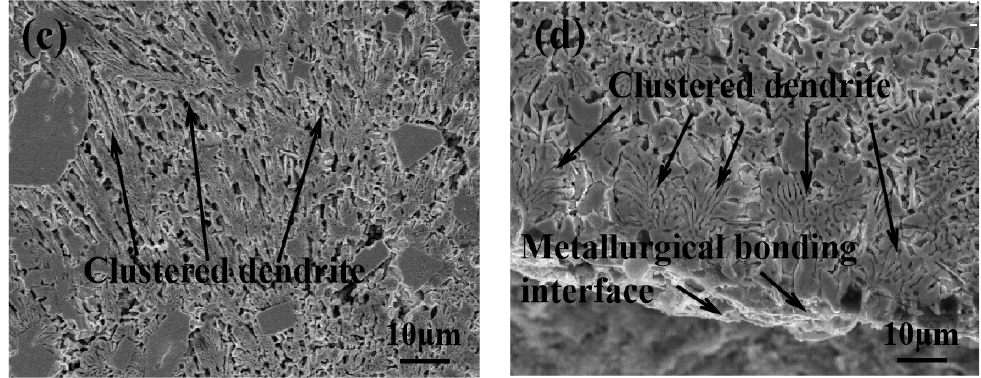
Figure 6. SEM images of certain areas of the composite coating containing 1.0% CeO 2 : ( a ) coating, ( b ) top, ( c ) bottom, and ( d ) interface.